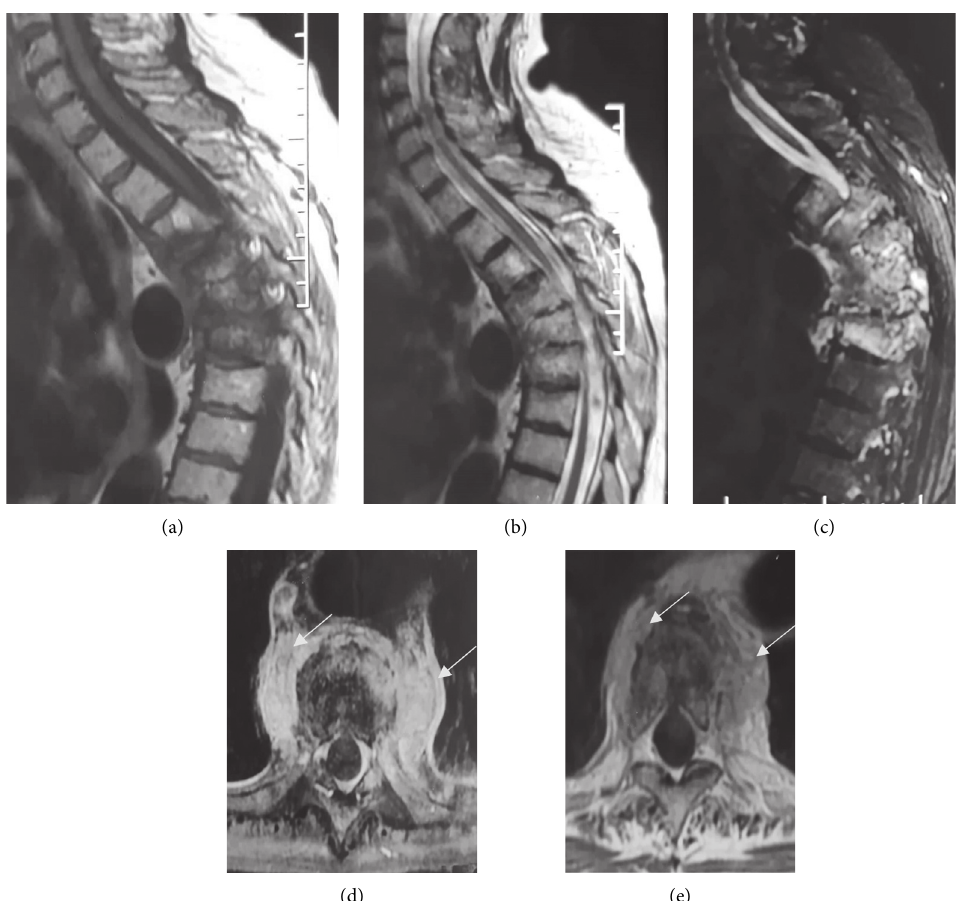
Figure 3: Magnetic resonance imaging. (a) Sagittal T1 WI, (b) sagittal T2 WI, and (c) sagittal STIR WI showing irregularity of the end plates from D4 to D7, high T2 signal in the disc, marrow signal change in the adjacent vertebra (T1 low and T2 high), and soft tissue mass (arrow). (d, e) Magnetic resonance imaging axial T1 after contrast showing soft tissue microabscess